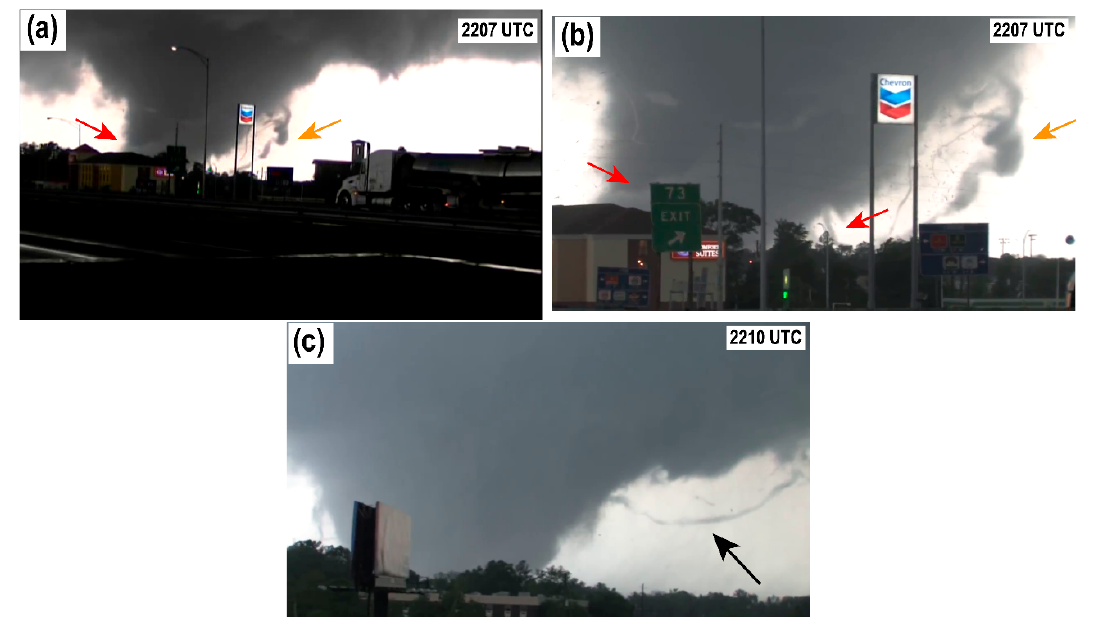
Figure 6. Visual observations of the 27 April 2011 Tuscaloosa tornado displaying several HVs. Video frames extracted from videos of ( a ) Mike Wilhelm (available online at: https://www.youtube.com/watch?v=T0FHTG9VETY) and ( b ) John Brown (available online at: https://www.youtube.com/watch?v=9KjWtBrEYHY), courtesy of Mike Wilhelm and Kory Hartman at SevereStudios.com, respectively. Red, orange and black arrows indicate key vortices discussed in the text. Other vortices are also evident in the figure. Tornado motion is due northeast (from left to right in the figure). Times in UTC are estimated.